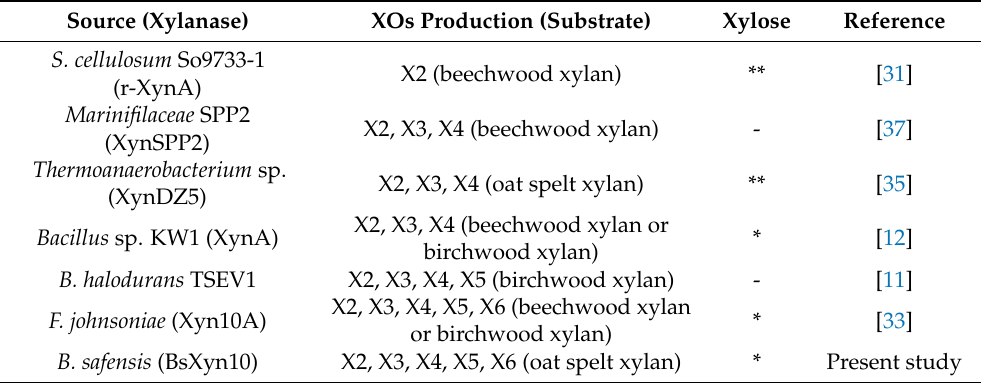
Table 6. The XO production of BsXyn10 and other GH10 xylanases of bacterial origin. Source